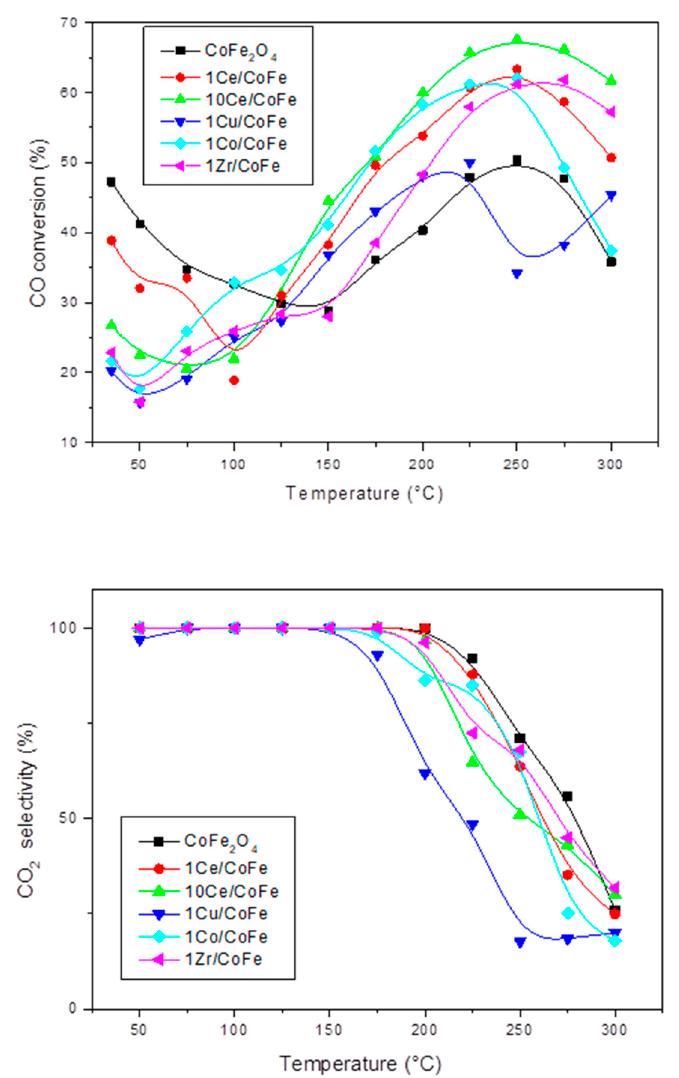
Figure 5. Catalytic activity results observed for the indicated catalysts under CO preferential oxi- dation (CO-PROX) conditions (1% CO, 1.25% O 2 , 50% H 2 and 0.2% H 2 O in He at 80,000 h − 1 ). Top: CO conversion; Bottom: O 2 selectivity to CO 2 .